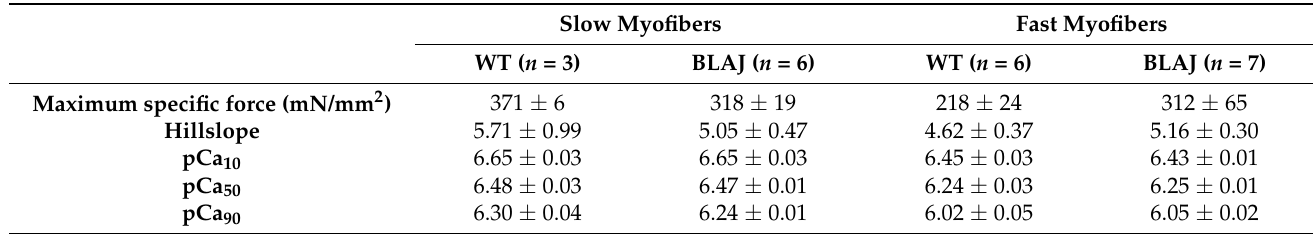
Table 2. Ca 2+ -activation properties of chemically skinned slow- and fast-twitch myofibers isolated from soleus and EDL muscles from normal WT and dysferlin-deficient BLAJ mice aged 3 months ( n = 2). There were no strain-specific differences for slow- or fast-twitch myofibers (classified by strontium sensitivity test) ( p > 0.05). Data are presented as mean ± SEM and analyzed by two-way ANOVA. Number of isolated myofibers analyzed indicated by n